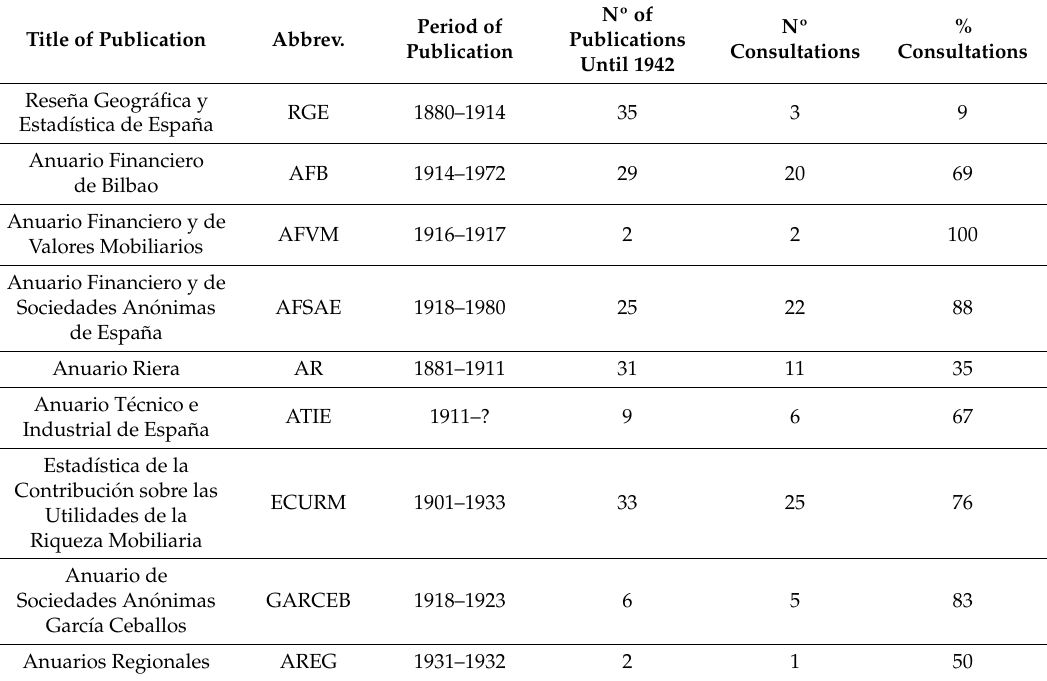
Table 1. Sources consulted on water